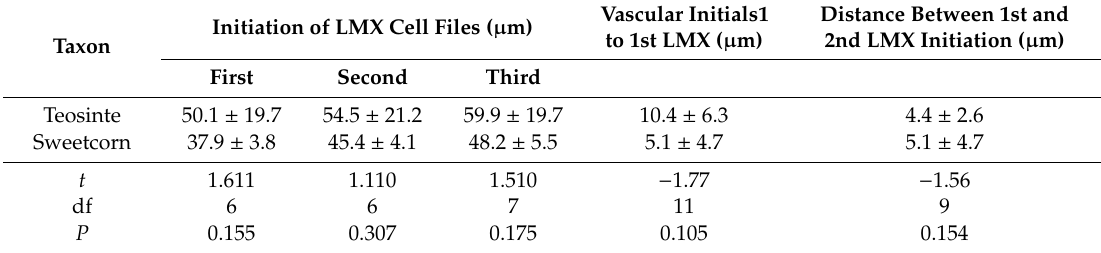
Table 2. Late-maturing metaxylem vessel (LMX) initiation data. Indicated are initiation distance of the first three LMX cell files measured from the root cap junction and distances from the basipetal face of the first layer of vascular initials (vascular initials1) to the most acropetal LMX cell and the distance between the initiation of the first and second LMX cell file. (Means ± std. dev., n = 7 each.) Measurements were not significantly di ff erent ( t -test, p = 0.05) between the taxa threshold due largely to high variation in teosinte. Statistics comparing column values are below each